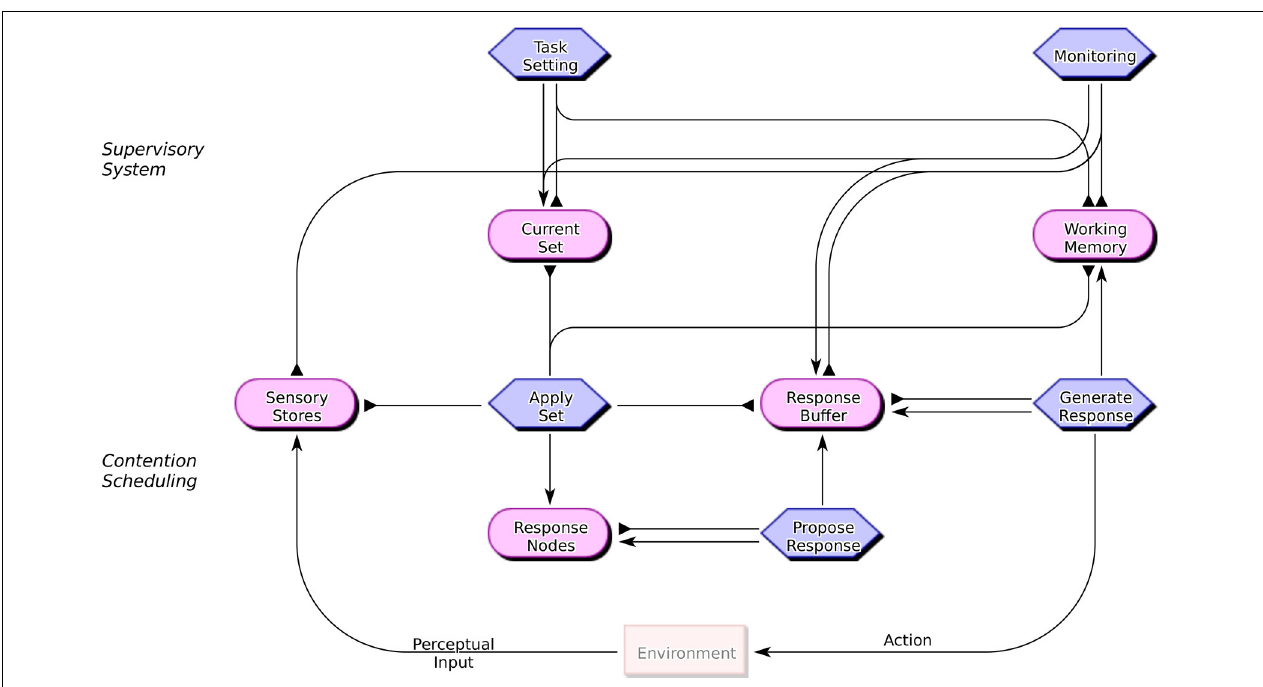
FIGURE 1 | Components of the Executive Subprocess (ESPro) architecture. Hexagonal boxes represent processes that generate output while rounded rectangles represent buffers that store representations